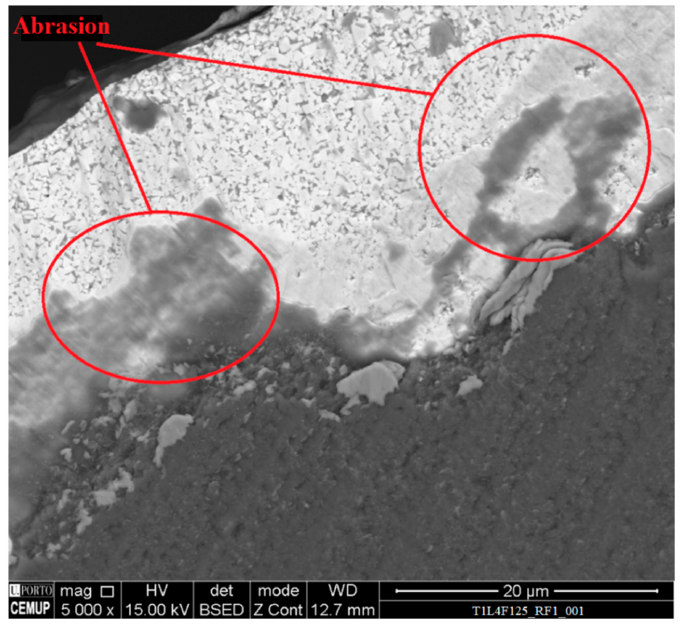
Figure 7. SEM image of the rake face of a T1L4F125 tested tool, at 5000 × magnification. The third, and last main wear mechanism registered was coating delamination, eventu- ally resulting in substrate exposure. This can be observed in Figure 8. Coating delamination was observed in all the tested tools, with tools tested at higher values of feed rate and cutting length exhibiting more delamination damage.